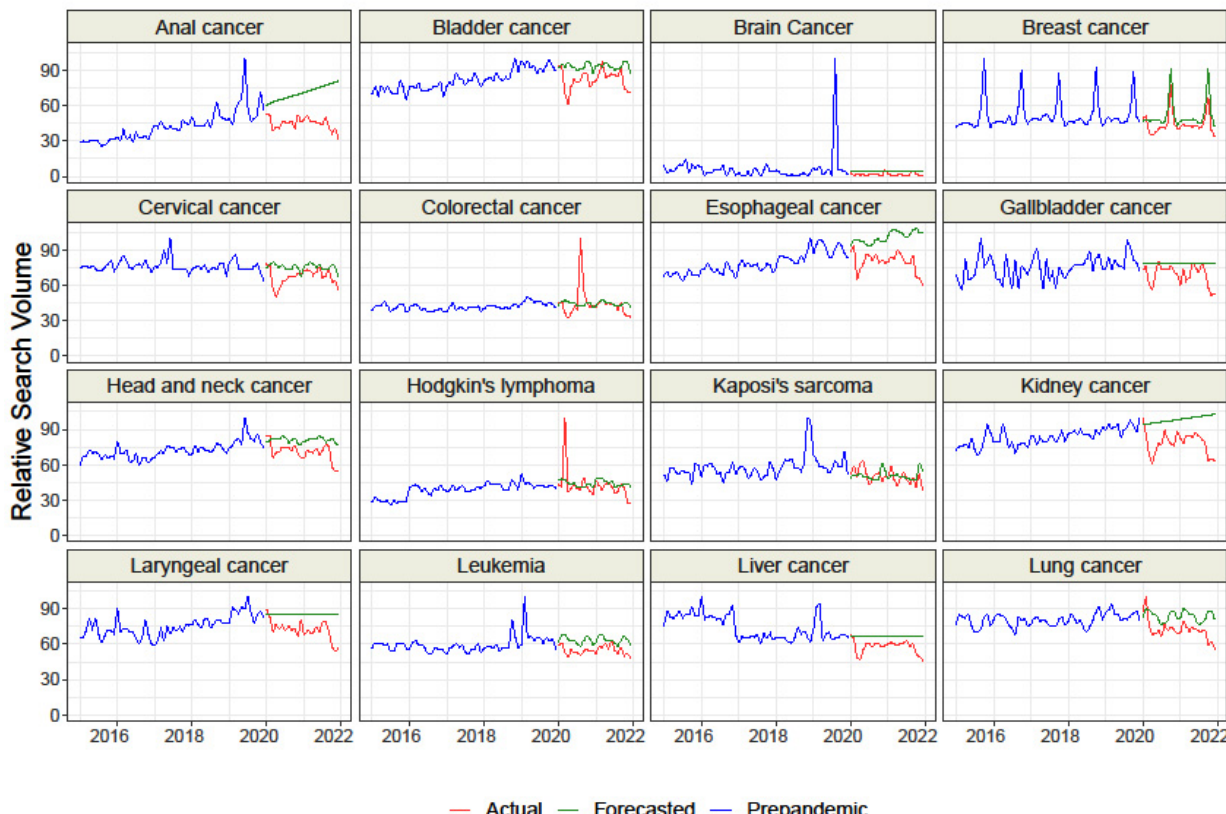
Figure 2. Relative Search Volume of Google queries on chosen malignancies.